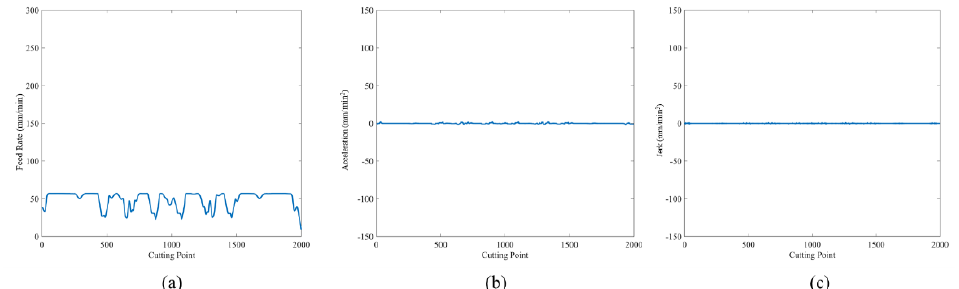
Figure 26. Cutting butterfly shape using method by Giannelli et al. [11]: ( a ) feed rate, ( b ) acceleration, and ( c ) jerk.